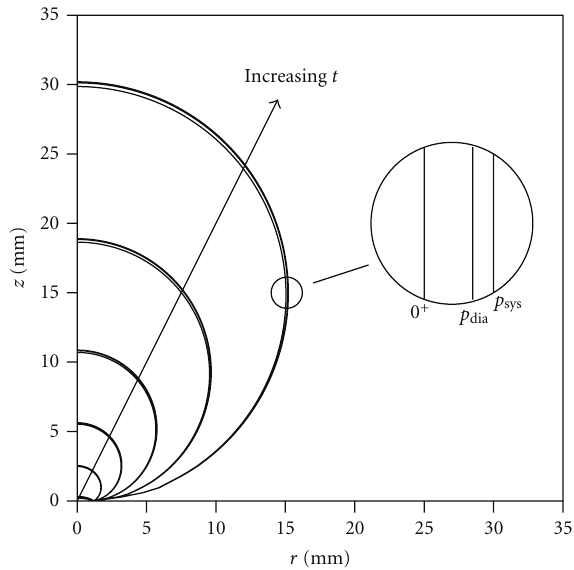
Figure 5: Predicted evolution of aneurysm geometry for α = 6 . 3. Aneurysm profiles are shown for the three pressure levels p = 0 + , p dia , p sys and for the times t / t cl = 0, 23, 46, 69, 92, and